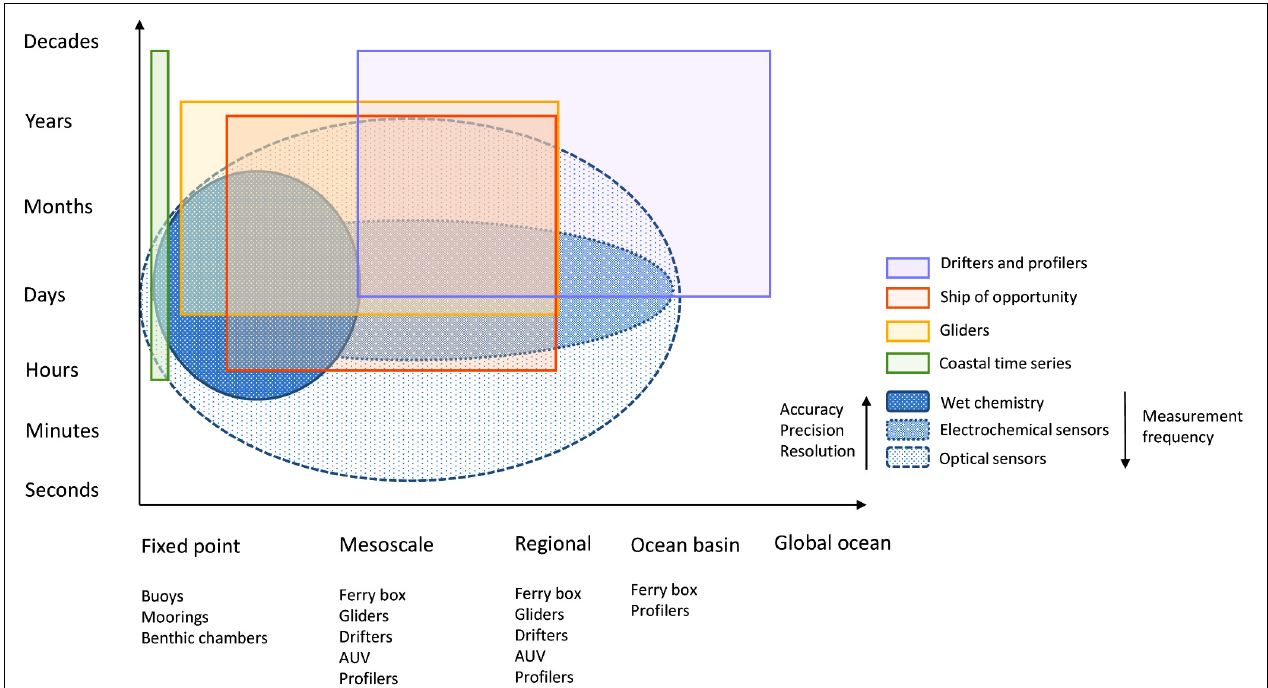
FIGURE 1 | Spatial and temporal coverage of various observing platforms and in situ nutrient sensors (adapted from Liblik et al.,